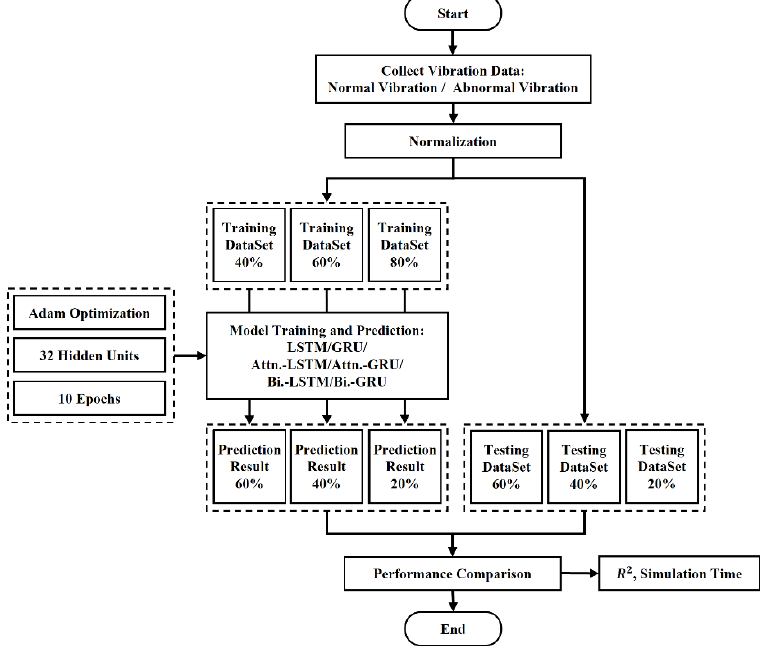
Figure 1. Flowchart of comparative analysis framework.